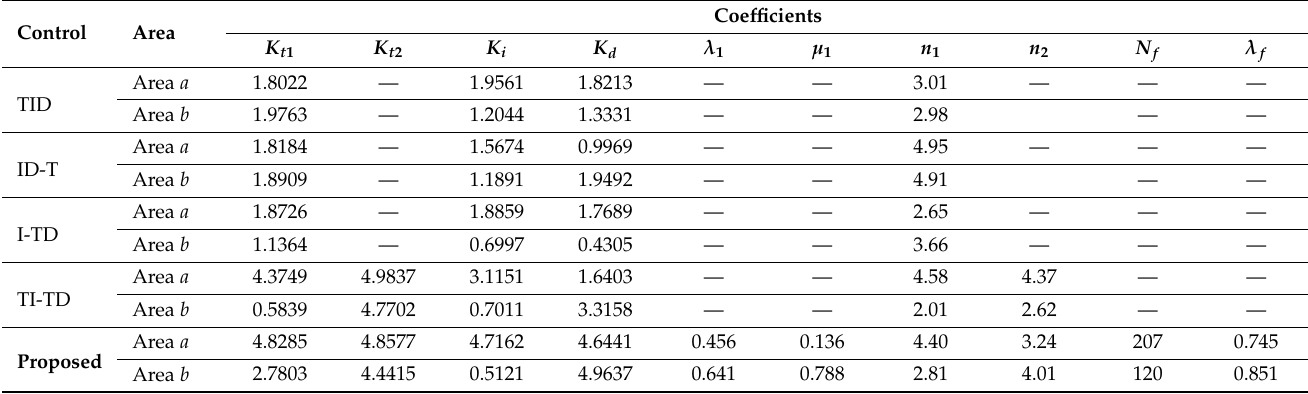
Table 9. The obtained optimal controllers parameters with the step load scenario.